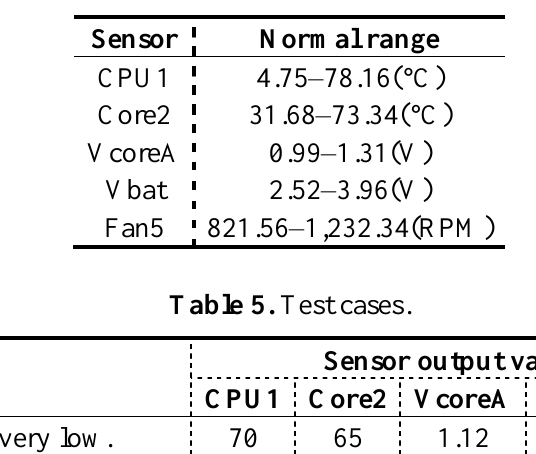
Table 4. Normal ranges derived from the balance formulas.